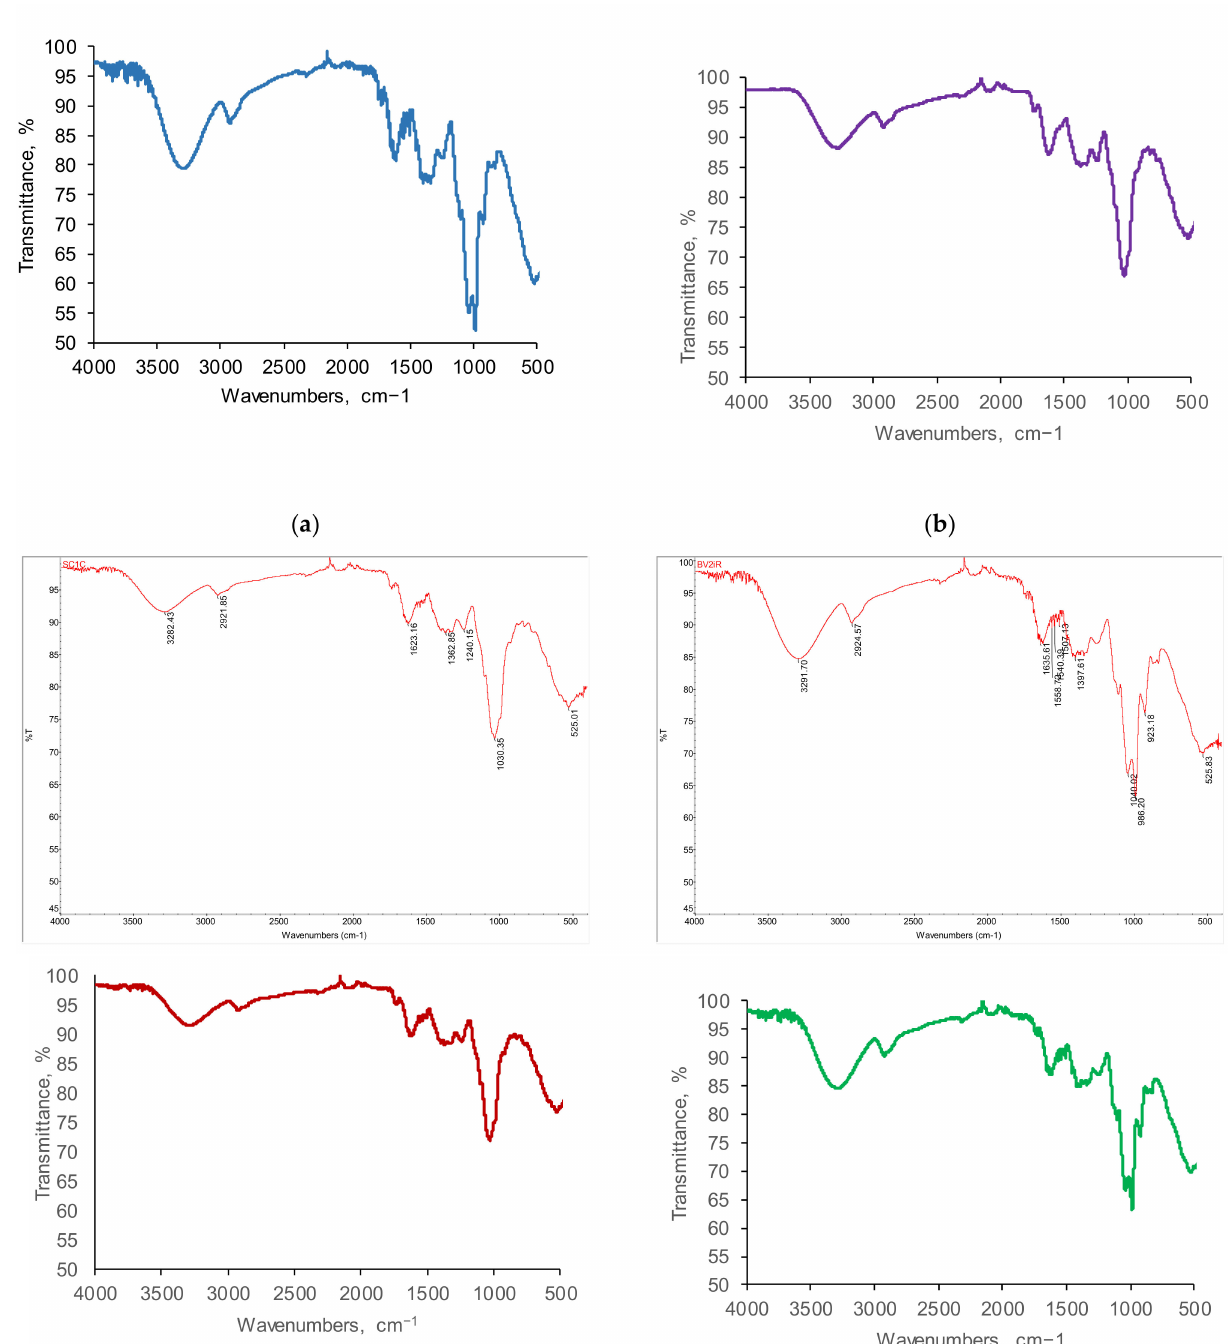
Figure 2. FT-IR spectra of analyzed plant extracts: ( a ) Origanum vulgare ; ( b ) Artemisia absinthium ; ( c ) Achillea millefolium ; ( d ) Primula veris